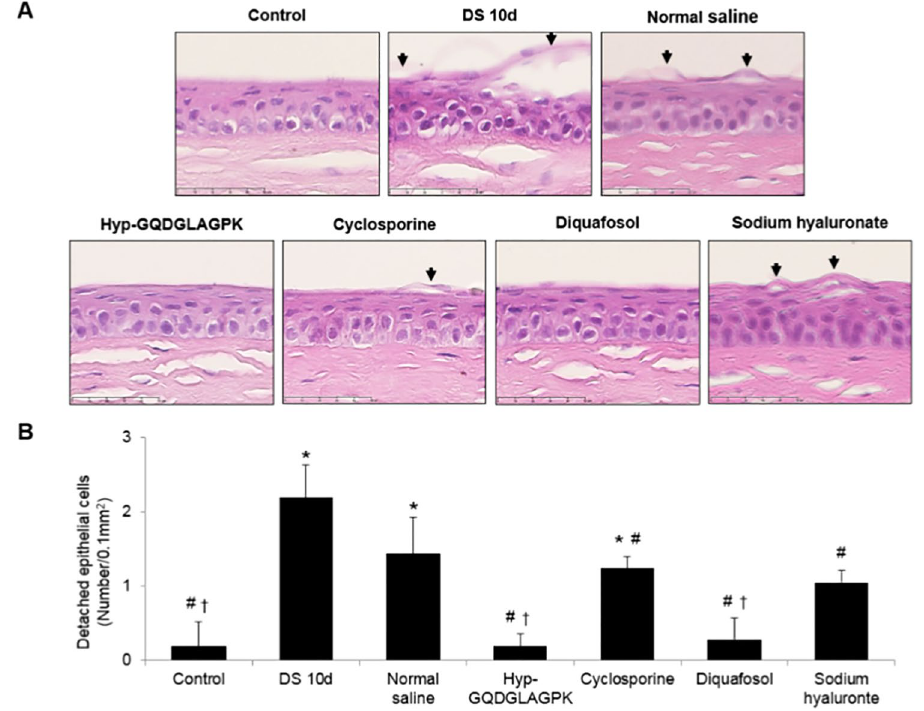
Figure 4. Effect of Hyp-GQDGLAGPK on the detachment of corneal epithelial cells. ( A ) The corneas of the NOD.B10. H2 b mice were stained with H&E before desiccation stress, immediately after desiccation stress for 10 days, and 10 days after treatment with Hyp-GQDGLAGPK, cyclosporine, diquafosol, and sodium hyaluronate eye drops. The arrows indicate detached corneal epithelial cells. Scale bar = 50 μ m. ( B ) The numbers of detaching corneal epithelial cells are expressed as the means ± the SD (n = 4~5 eyes). The results are statistically significant by analysis of variance with the Tukey test at * p < 0.05 compared with baseline, # p < 0.05 compared with DS 10d and † p < 0.05 vs corresponding value in the normal saline